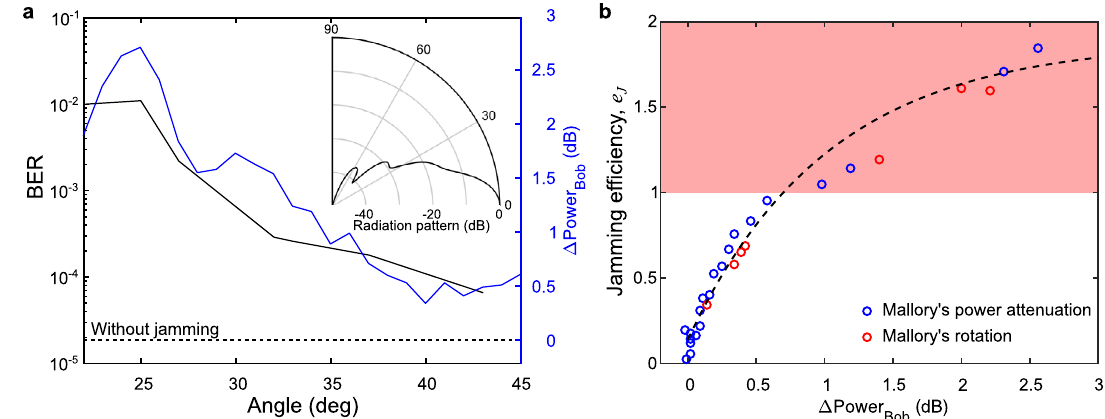
Fig. 3 Angle of attack and jamming ef fi ciency. a Mallory can reposition herself angularly to attack Bob ’ s side lobes (inset), which allows her to disrupt the bit-error rate (BER) and control the ef fi cacy of her jamming. Mallory can consistently increase Bob ’ s BER up to 43 deg (black line) compared to if Mallory was not present (black dotted line). The inset shows the radiation pattern of Bob ’ s receiver and was simulated with a fi nite element method. b Alternatively, Mallory can pick an angular position respective to Bob ( θ M = 22°) and increase her transmit power, effectively adding power to Bob ’ s measurement Δ Power , and increasing the jamming ef fi ciency. The striped black shows an exponential fi t of the data (see “ Methods ” for details). As bob Mallory ’ s transmit power increases, she can increase Bob ’ s BER up to 1.7 · 10 − 3 when transmitting a signal of 10.7 dBm, relative to Alice transmitted power of − 10.5 dBm. The red region corresponds to a completely jammed signal as de fi ned in the text following Eq.